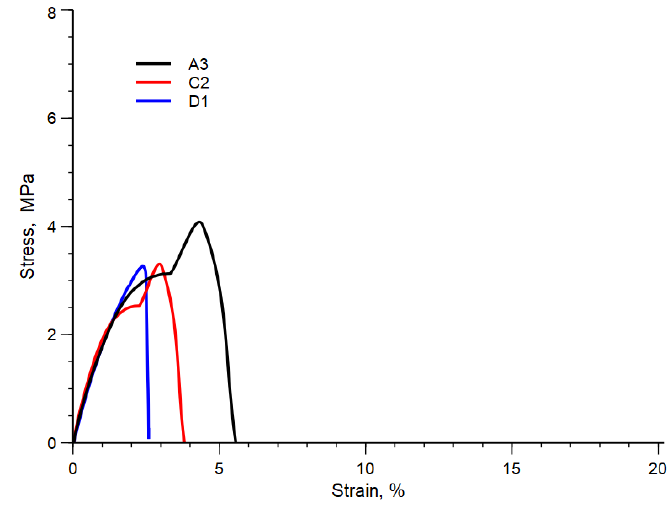
Figure 5. Stress-strain curve of A3, C2 and D1 blends.